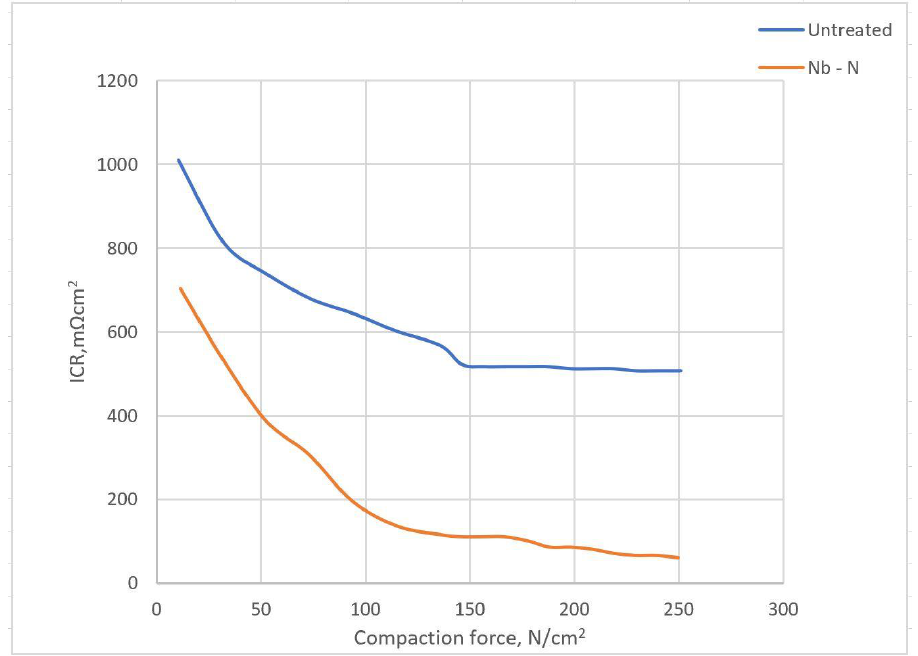
Figure 5. Coated 304 SS with Nb-N coating and uncoated 304 SS of interfacial contact resistance with contact force [60].